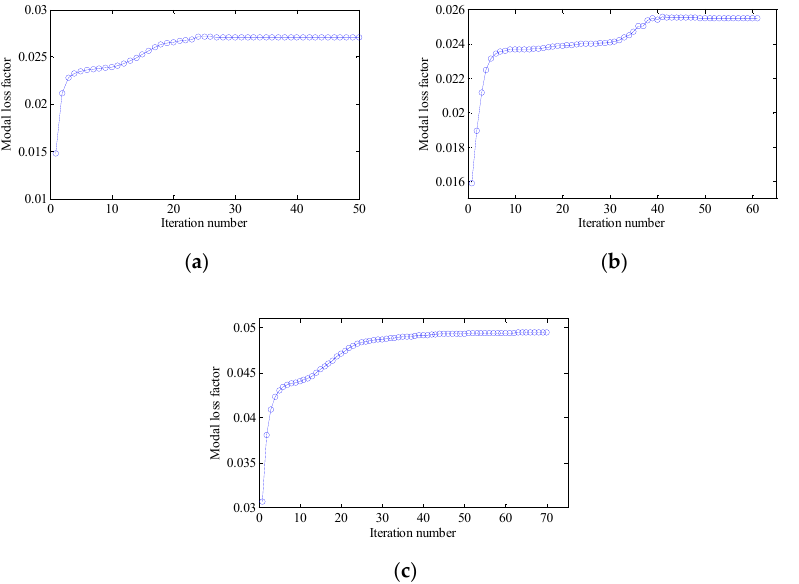
Figure 21. Iteration histories for different optimization objectives: ( a ) Objective 1: maximizing the first modal loss factor; ( b ) Objective 2: maximizing the second modal loss factor; ( c ) Objective 3: maximizing the sum of the first two modal loss factors. Table 5. Comparison of the modal loss factors between optimized structure and full coverage structure (bold italics denote the modal loss factor of objective mode).